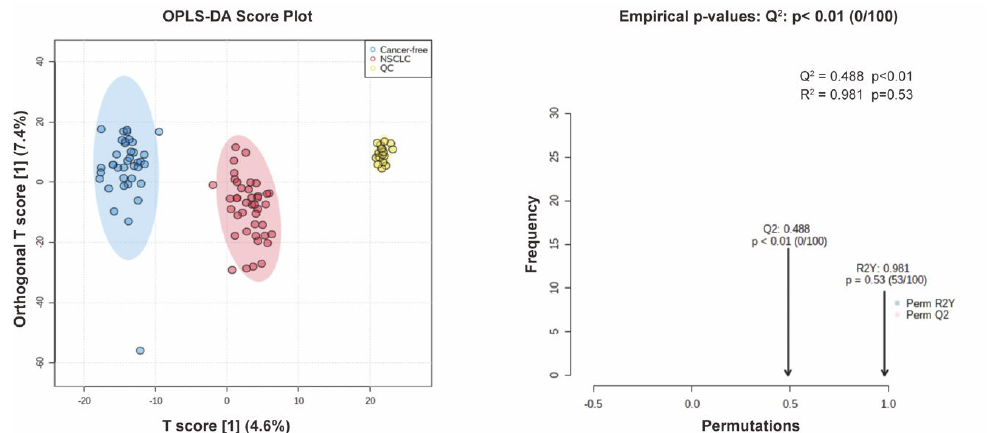
Figure A2. OPLS-DA score plot between NSCLC and cancer-free controls and the permutation test of